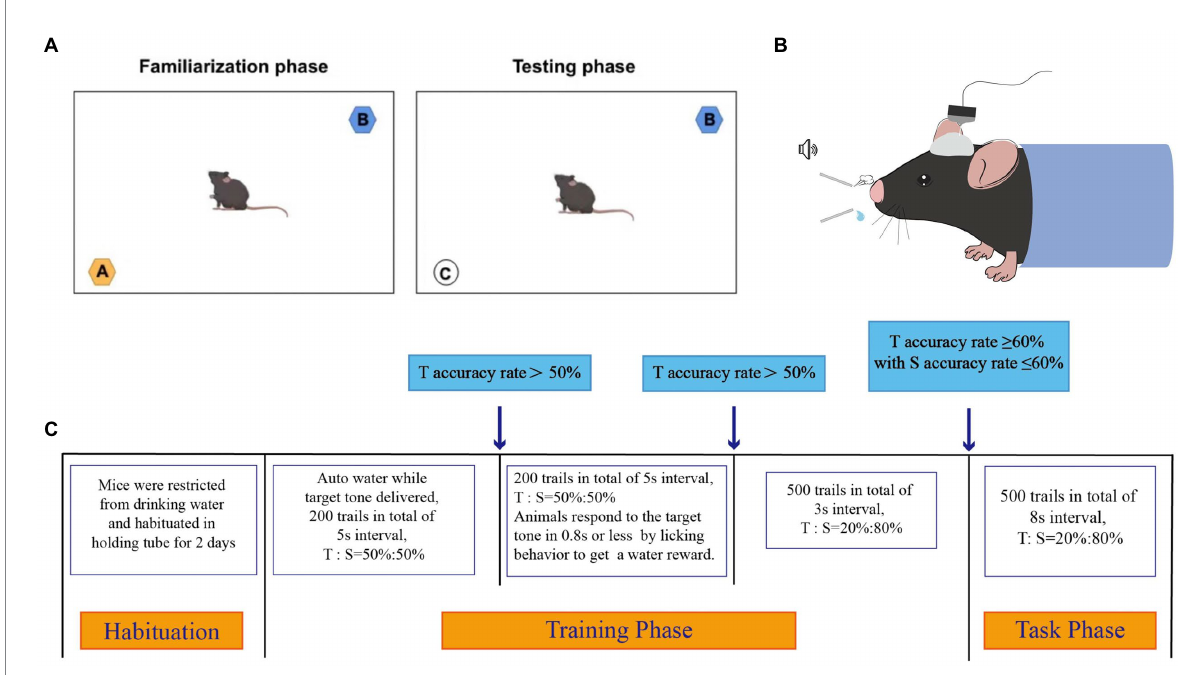
FIGURE 1 The schematic diagram of novel object test and oddball paradigm behavior training. (A) Schematic diagram of novel object test. A dark open-field box (40 * 40 * 45 cm) was used. The objects shown to the mice were a smooth pebble, a blue cap of the same size and form, and a orange cap of the same size and form, respectively. (B) Schematic diagram of oddball paradigm behavior training. (C) Schematic presentation of different phases of the Oddball paradigm behavior Training. Animals had to correctly respond to infrequent target (8 Hz) tones while correctly ignoring infrequent standard (6 Hz) tones. The electrical signals of the mice were recorded during the task phase. T referred to Target tone, S referred to Standard